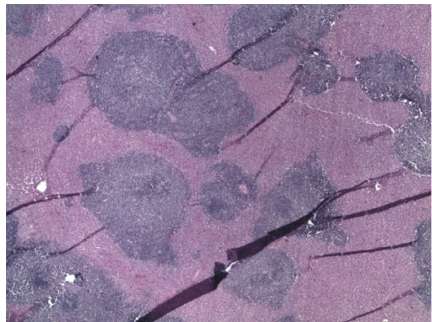
Figure 2: Liver tissue with a nodular pattern of lymphocytic infiltration